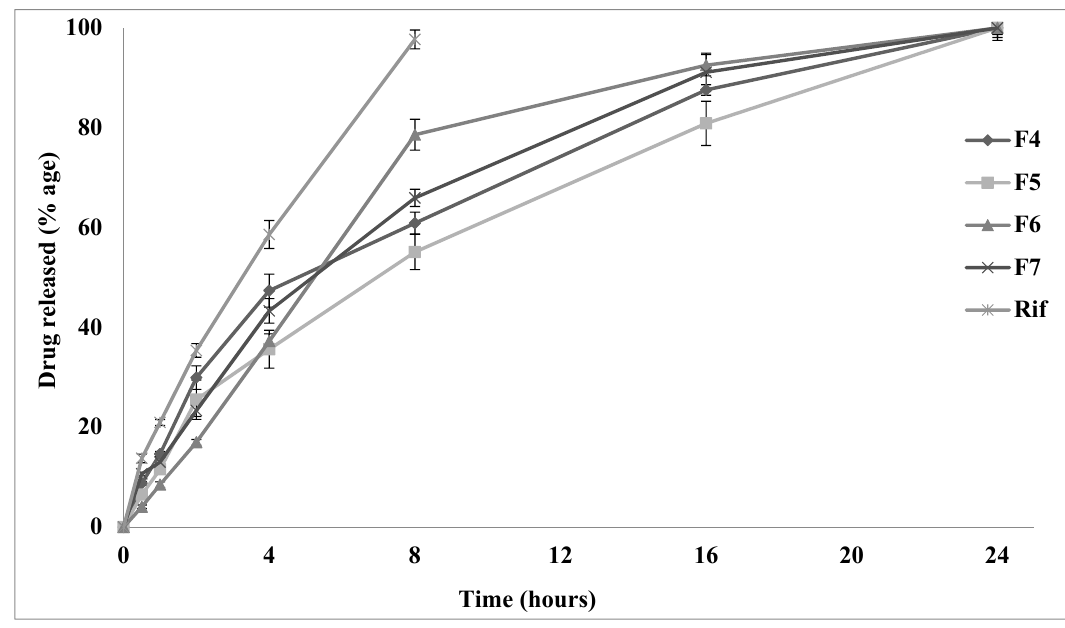
Figure 5. In vitro release profile of rifampicin from spray-dried microparticles (F4–F7) and pure rifampicin. Table 4. The correlation coefficient (R 2 ), n value and rate constant (K) of Korsmeyer–Peppas model equation for spray-dried rifampicin microparticles.